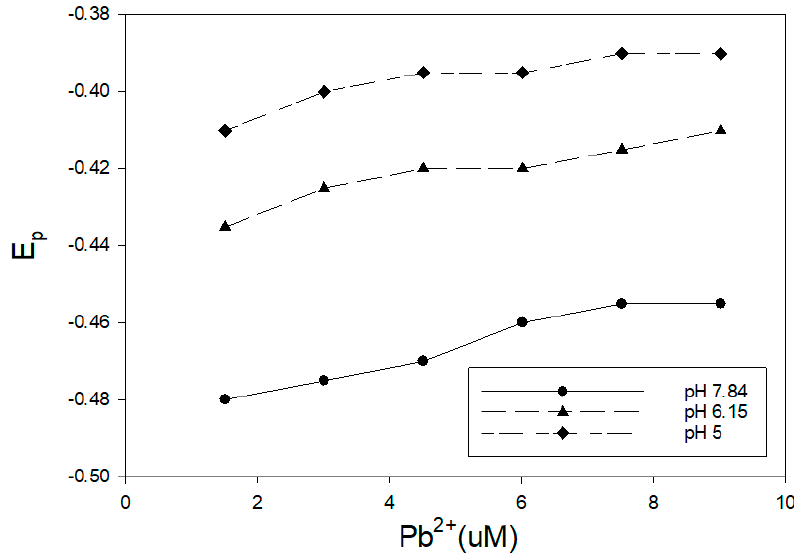
Figure 12. Comparison of DPP results for Pb 2+ in the presence of a creosote soil extract at three different pH values.